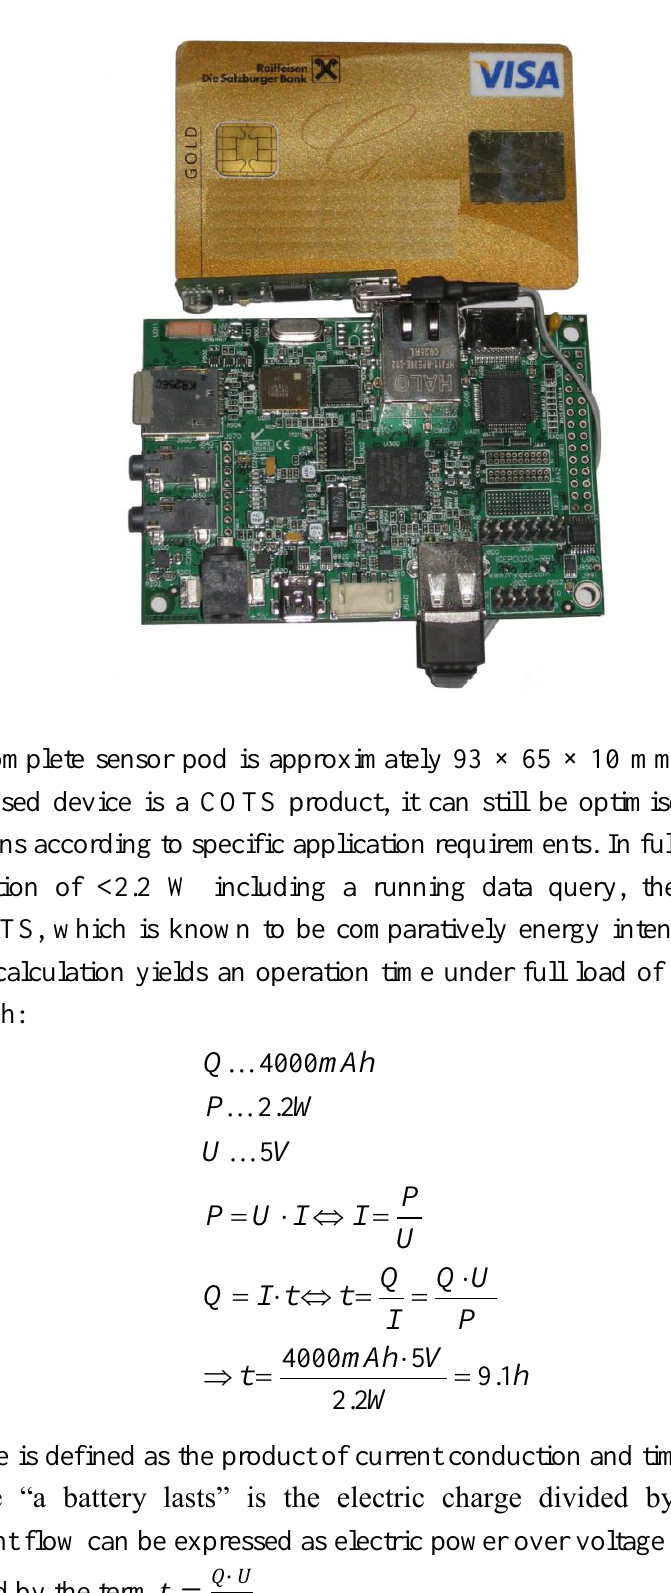
Figure 6. ISEE IGEPv2 with GPS and a Combined Air Temperature and Humidity